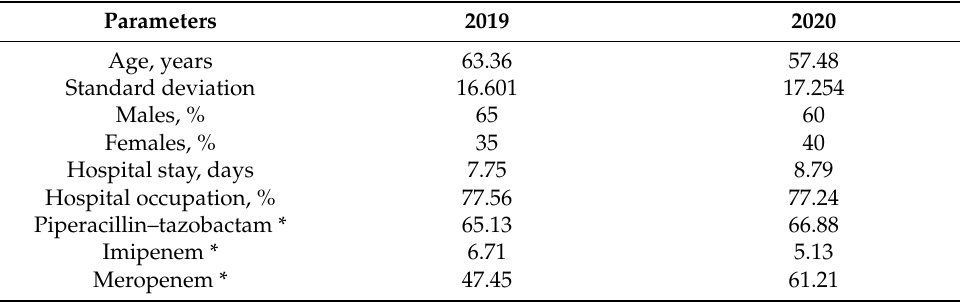
Table 6. Clinical data for episodes of carbapenemase-producing